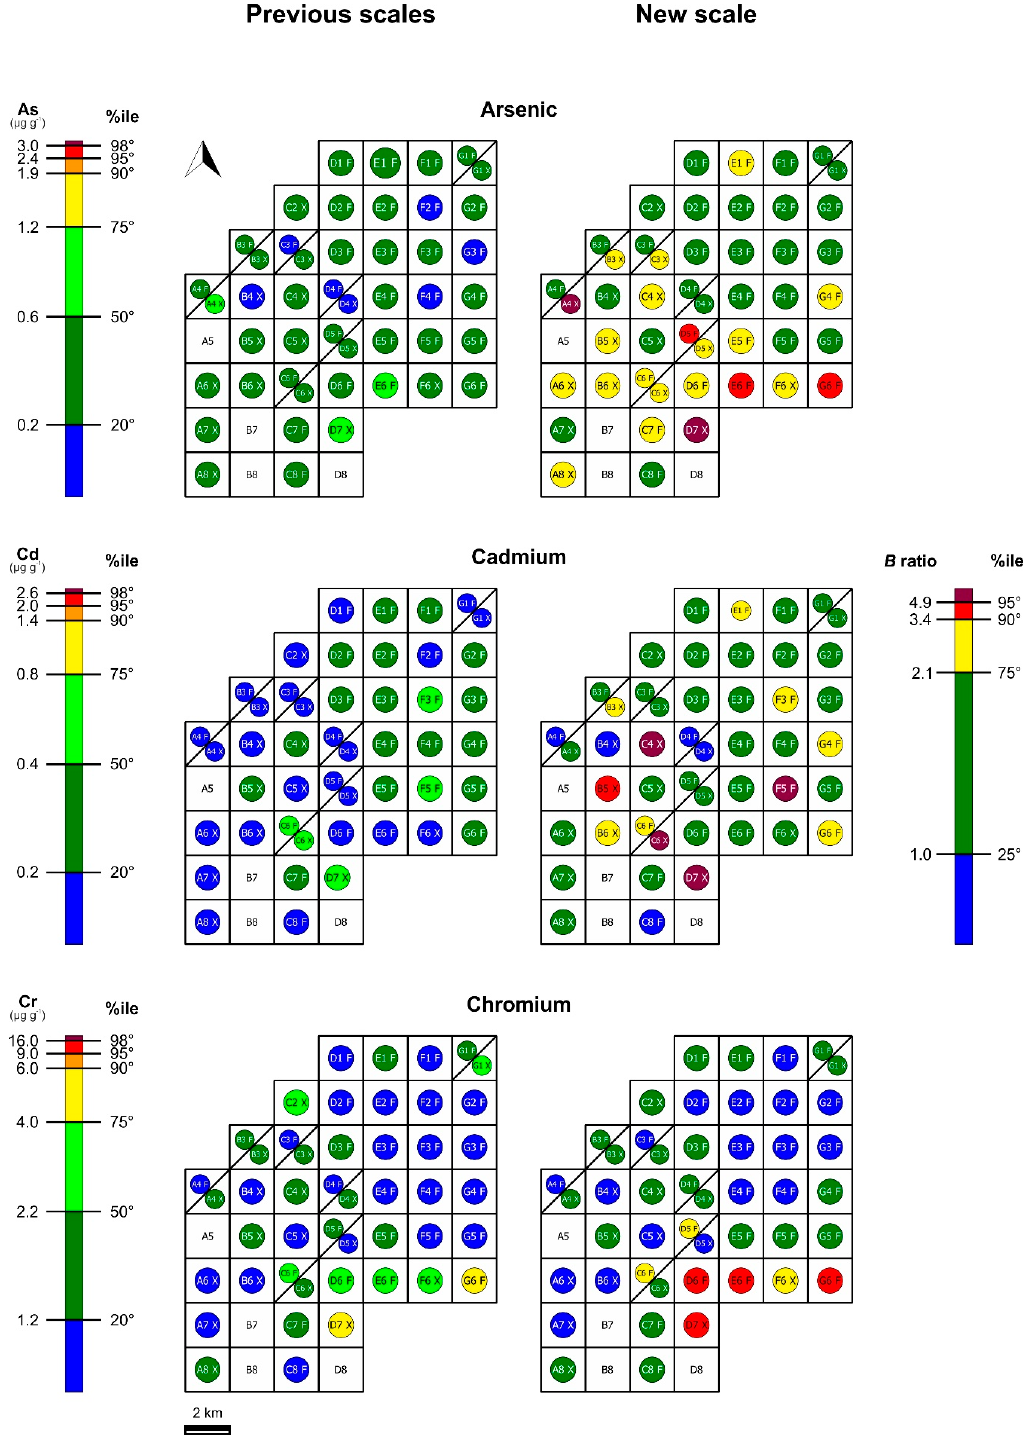
Figure 3. Cartographic representation of sampling sites and corresponding classes of the naturality/alteration scale [16] (here, “previous scales”) and bioaccumulation scale (Table 4; here, “new scale”), with indication of percentile thresholds (%ile), corresponding element concentration values (left), and B ratios (right). Sampling sites are identified by alphanumeric codes (as also reported in Table S5) followed by the letter F or X for Flavoparmelia caperata and Xanthoria parietina , respectively.